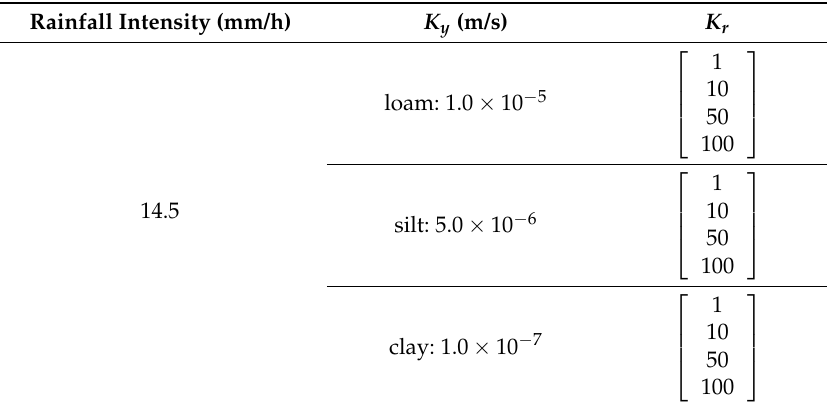
Table 3. Case design for hydraulic conductivity